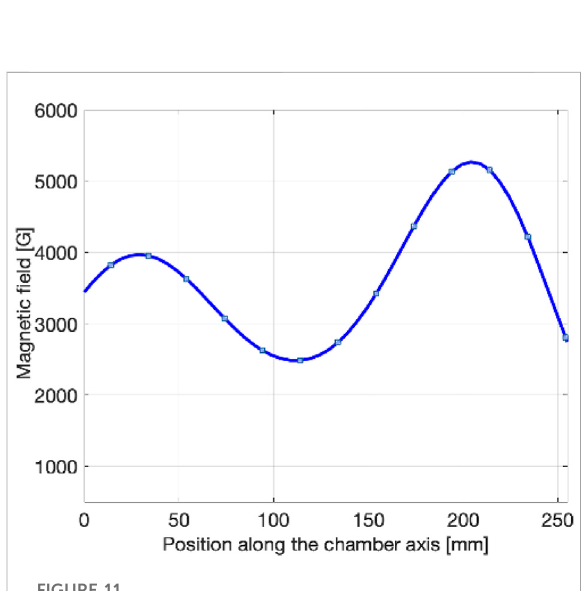
FIGURE 11 Simple-mirror con fi nement magnetic fi eld pro fi le of FTP.